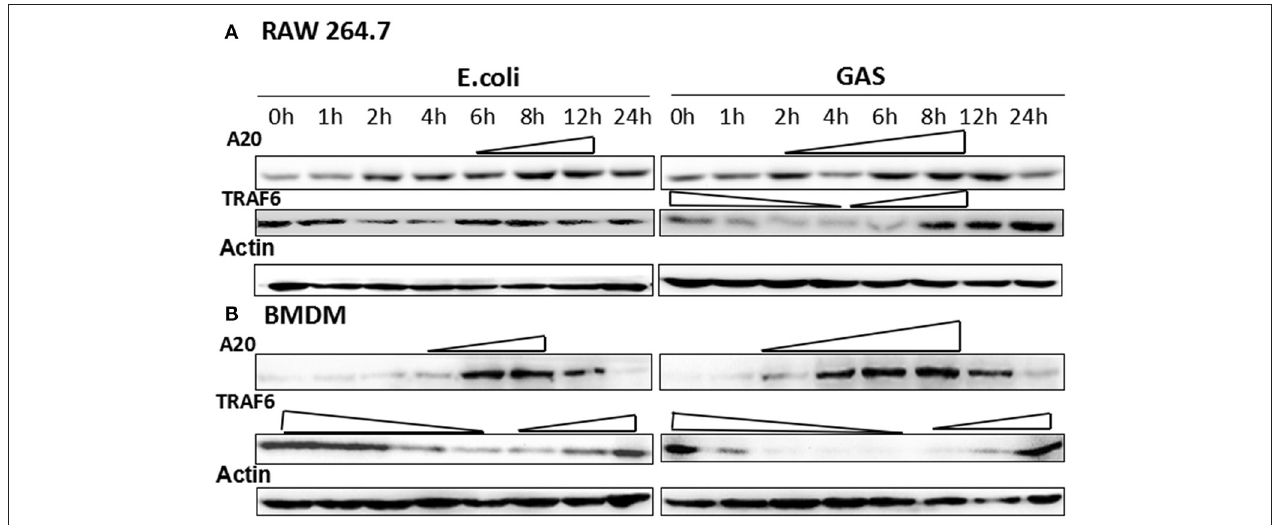
FIGURE 3 | Expression of A20 and its target protein, TRAF6, in GAS-induced macrophages. Macrophages from wild-type mice were infected with GAS or E. coli at an MOI of 10. At different post-infection times, the protein levels of A20 and TRAF6 were detected by Western blot in RAW 264.7 cells (A) or BMDMs (B) . Each experiment was repeated three times, and similar results were obtained on each occasion.